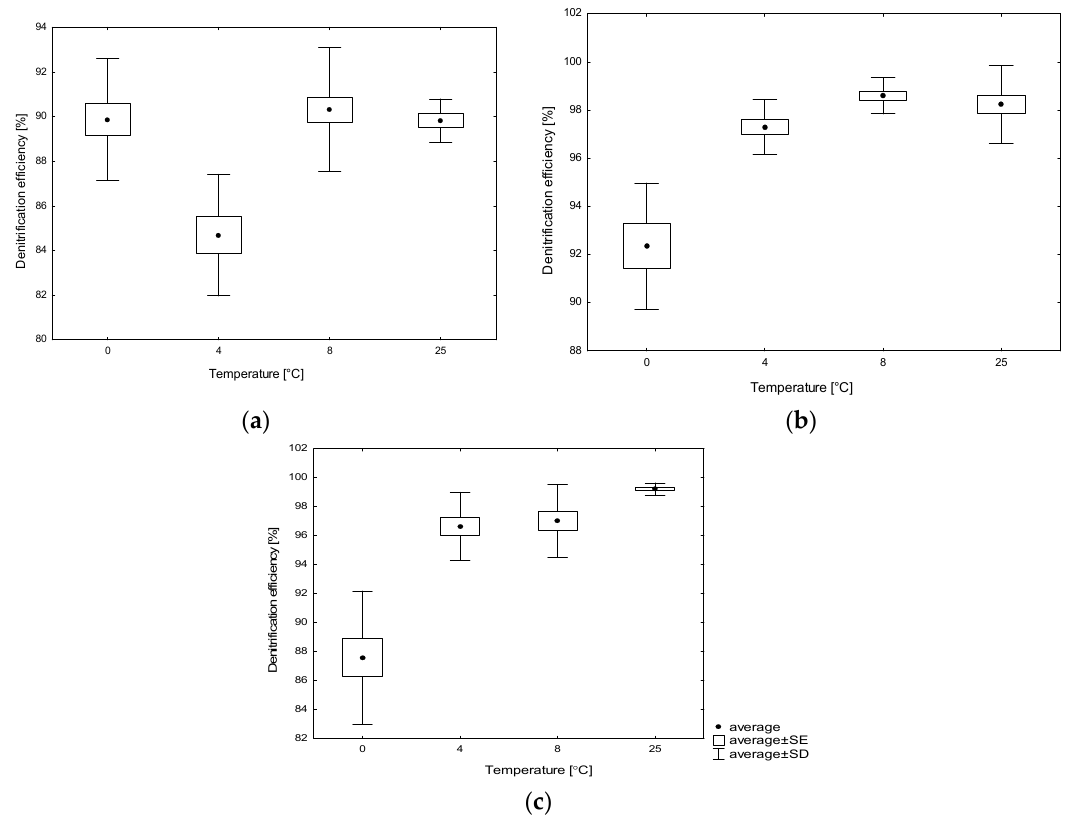
Figure 5. Influence of temperature on the denitrification efficiency in: ( a ) series 1 (C/N = 0.5 gC/gN), ( b ) series 2 (C/N = 2.5 gC/gN), ( c ) series 3 (C/N = 5.0 gC/gN).